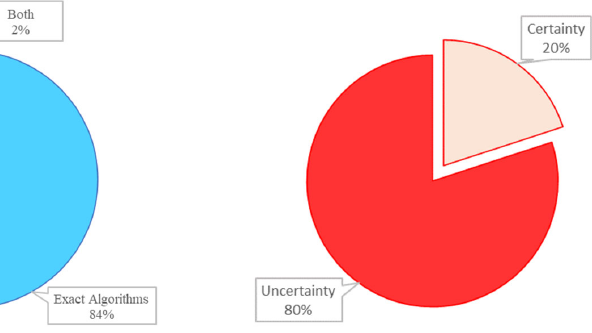
Fig. 8. Category of Solution Technique Fig. 9. Category of Parameters